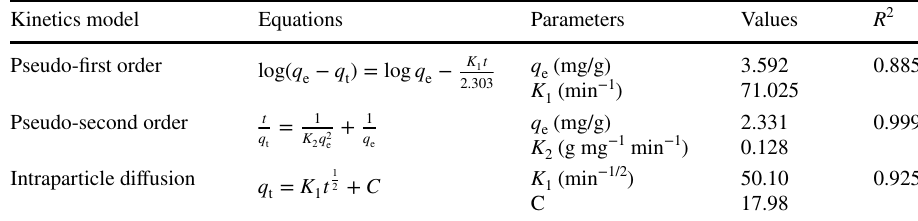
Table 2 Summary of parameters for various kinetic models by mosambi peel